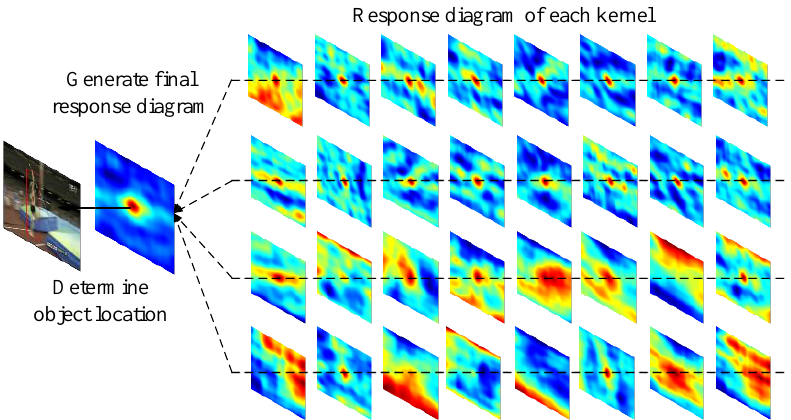
Figure 4. The response maps of different convolution kernels in response to the object’s position ( “ jump ” video sequence).